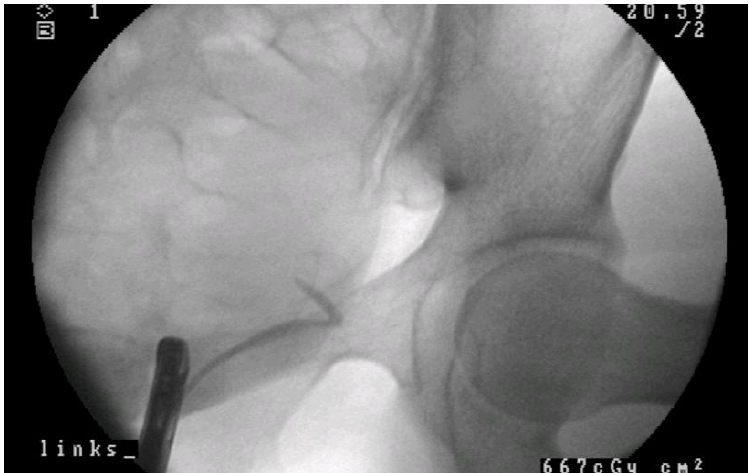
FIGURE 1. The ureteral catheter could not be inserted more than 3 cm into the left